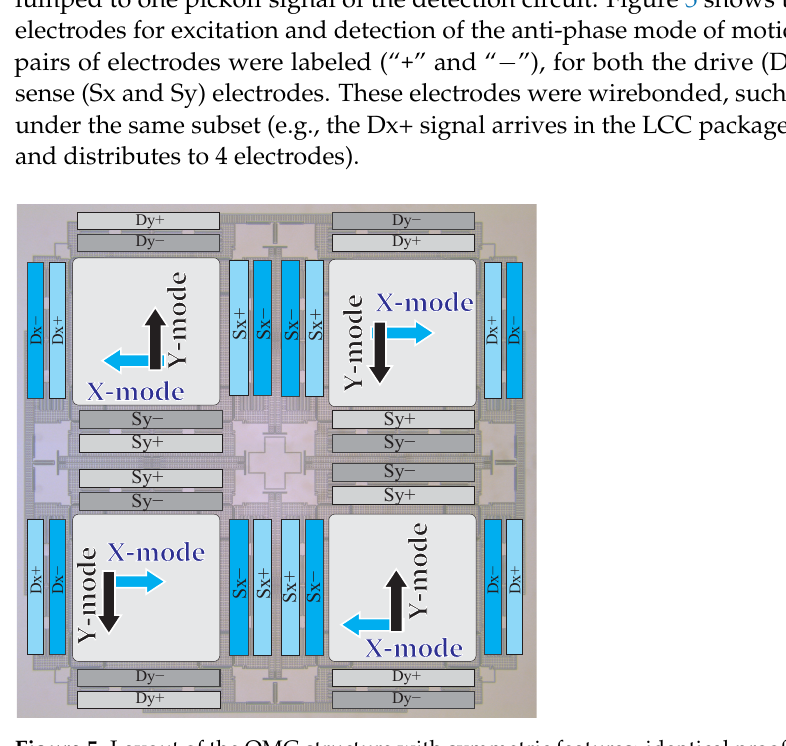
Figure 5. Layout of the QMG structure with symmetric features: identical proof-masses and identical drive and sense electrode structures overlaid with external forcers and internal pickoff electrodes, which are used to drive and sense each mode